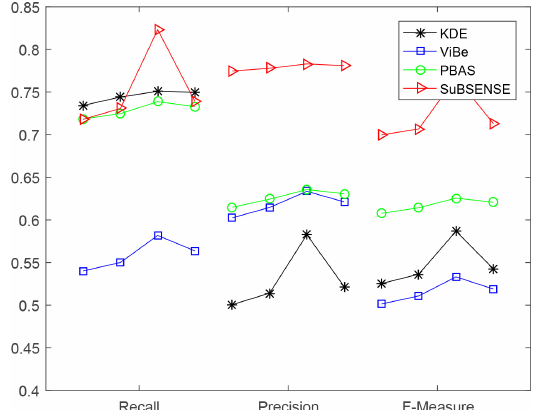
Figure 9. The tendency of each performance indicator of each host method by executing method “NoIV-1” one time, two times, four times, and seven times, respectively, in the combined model. In each broken line, the four vertices represent the four kinds of the different number of times of executing the method